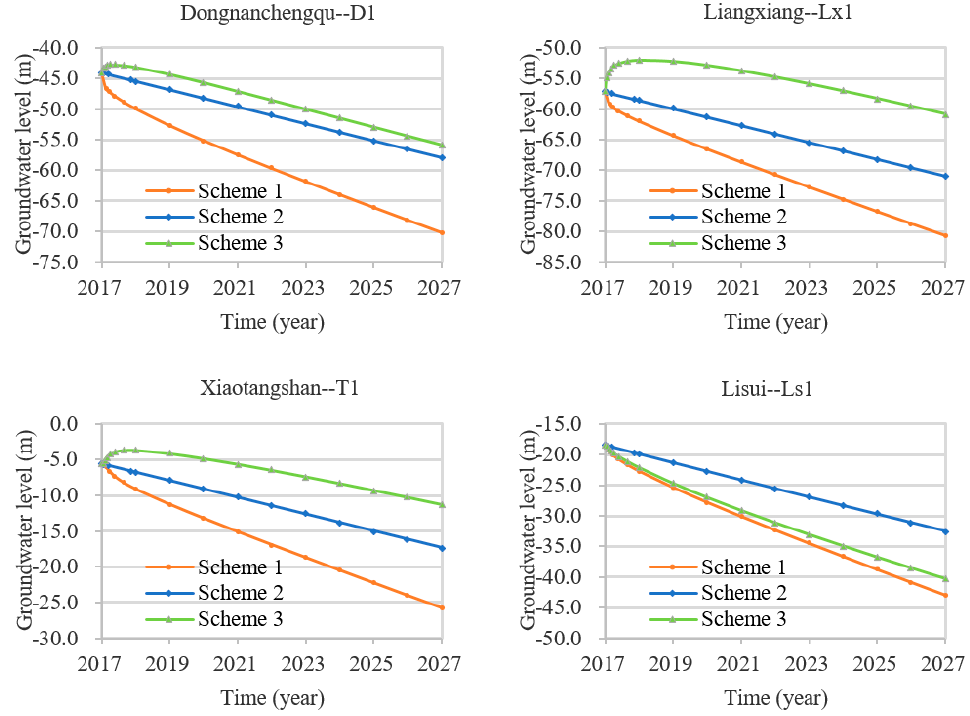
Figure 17. Curves of simulated hydraulic heads during the predicted period.